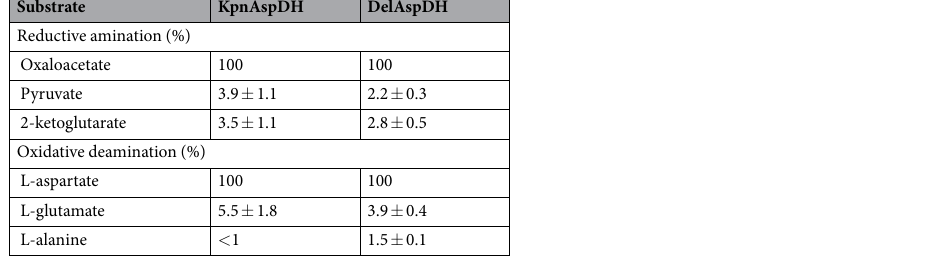
Table 3. Substrate specificities of KpnAspDH and